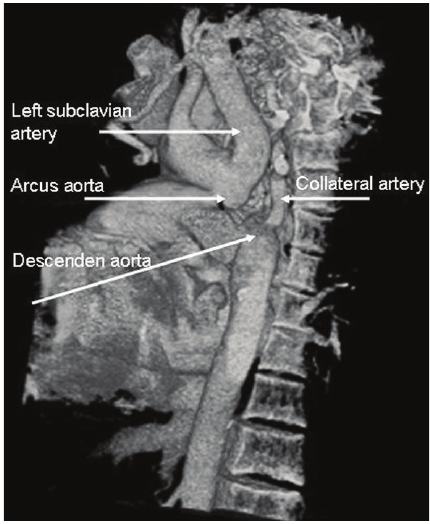
Figure 2: Three-dimensional reconstruction image showing type A interrupted aortic arch with collateral artery near the descending